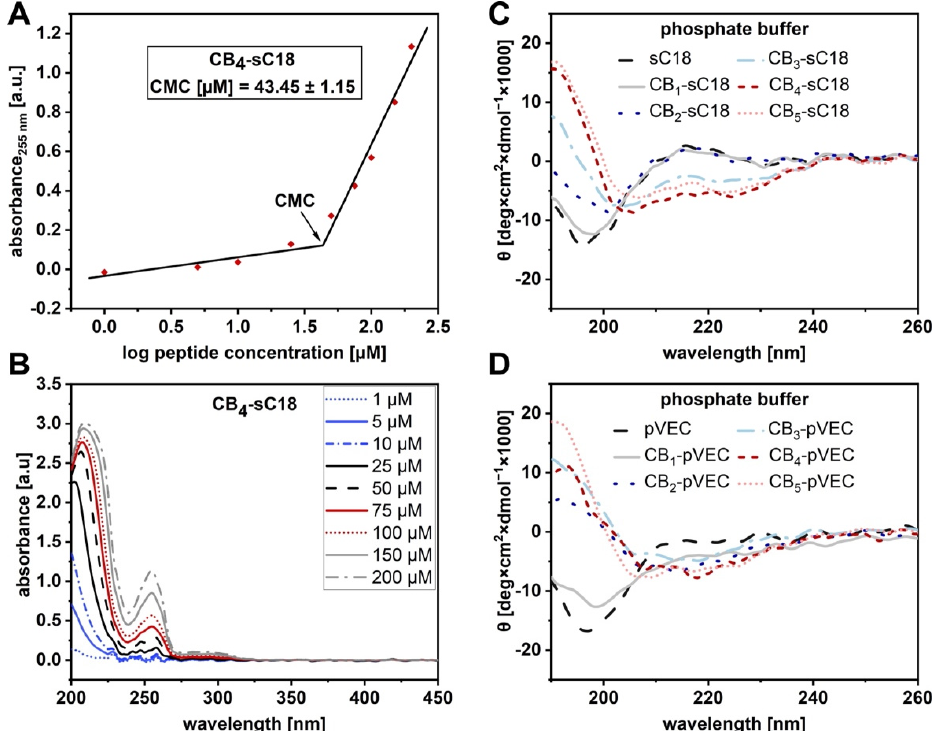
Figure 1. Determination of CMC and CD spectra of CB-CPP conjugates. ( A ) The determination of CMC for CB 4 -sC18 is shown by measuring the UV-VIS spectra at various concentrations ( B ). ( C ) CD spectra of CB-sC18 conjugates in phosphate buffer. ( D ) CD spectra of CB-pVEC conjugates in phosphate buffer. Table 2. Percentage of α -helical content [31], and determined R-values of CB-sC18 and CB-pVEC conjugates calculated as the ratio between the molar ellipticity values at 222 and 208nm [32].